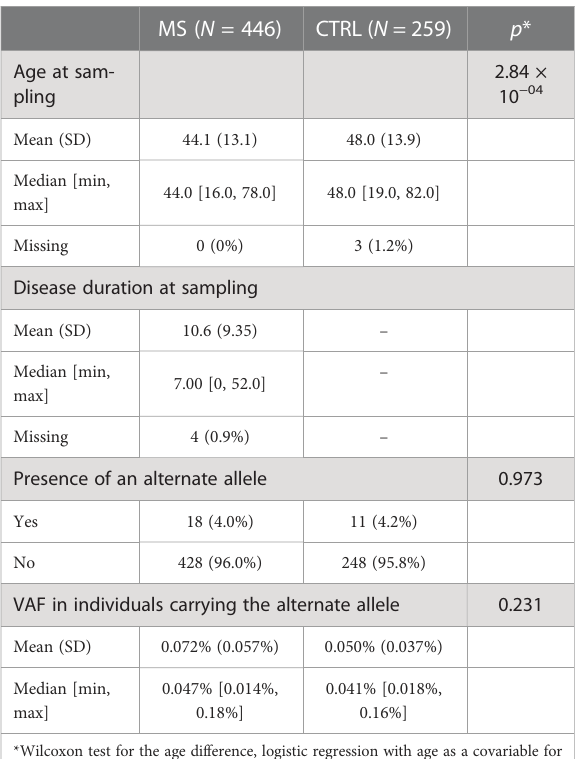
TABLE 2 Detection of STAT3 p.Y640F somatic variant in the peripheral blood of MS patients and